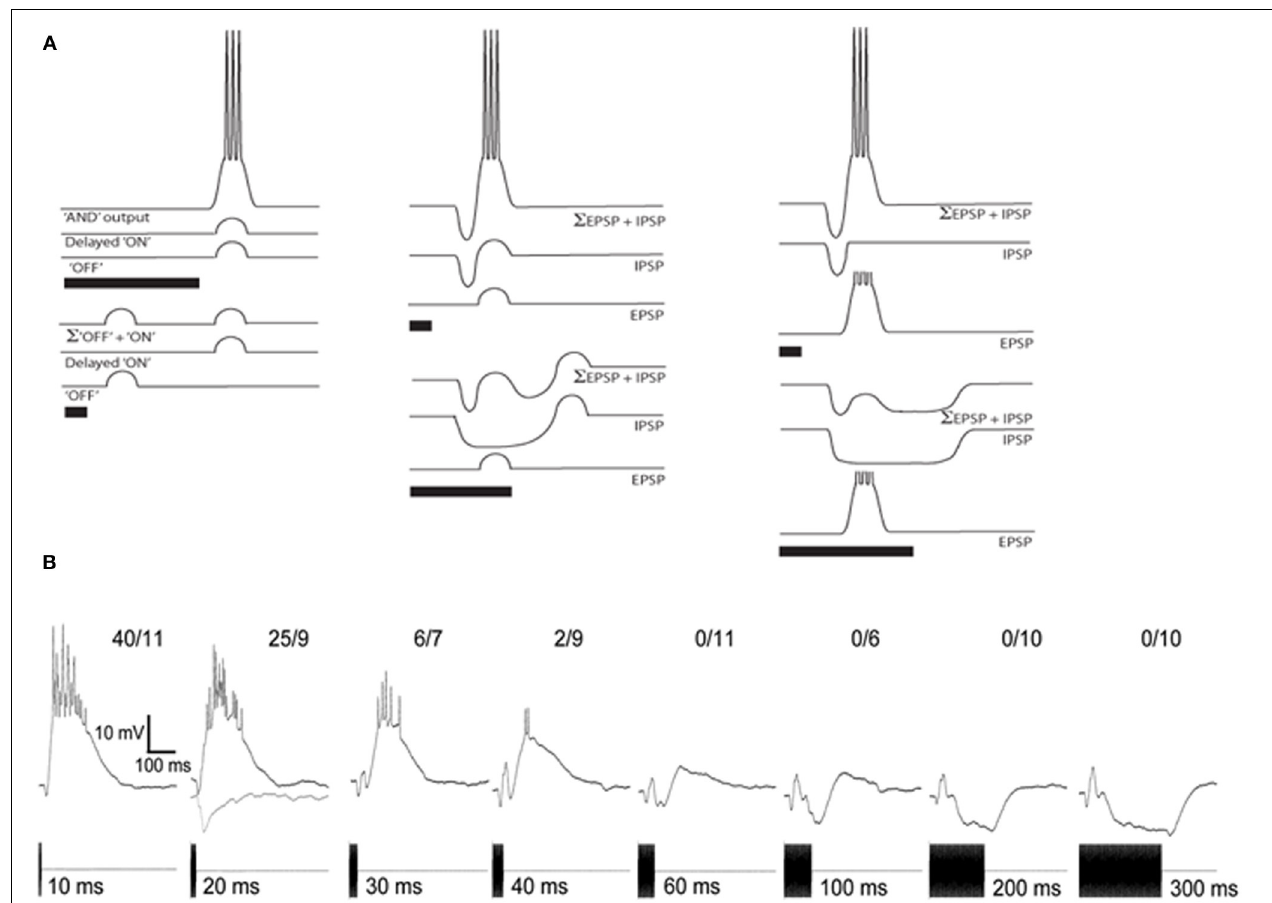
FIGURE 4 | (A) Models of duration selectivity proposed by (Narins and Capranica, 1980) (left); (Casseday et al., 1994) (middle); and (Fuzessery and Hall, 1999) (right). For each stimulus condition, traces depict the excitation alone (EPSP), inhibition alone (IPSP), and combined ( (cid:2) EPSP + IPSP). (B) Averaged responses of a short-pass